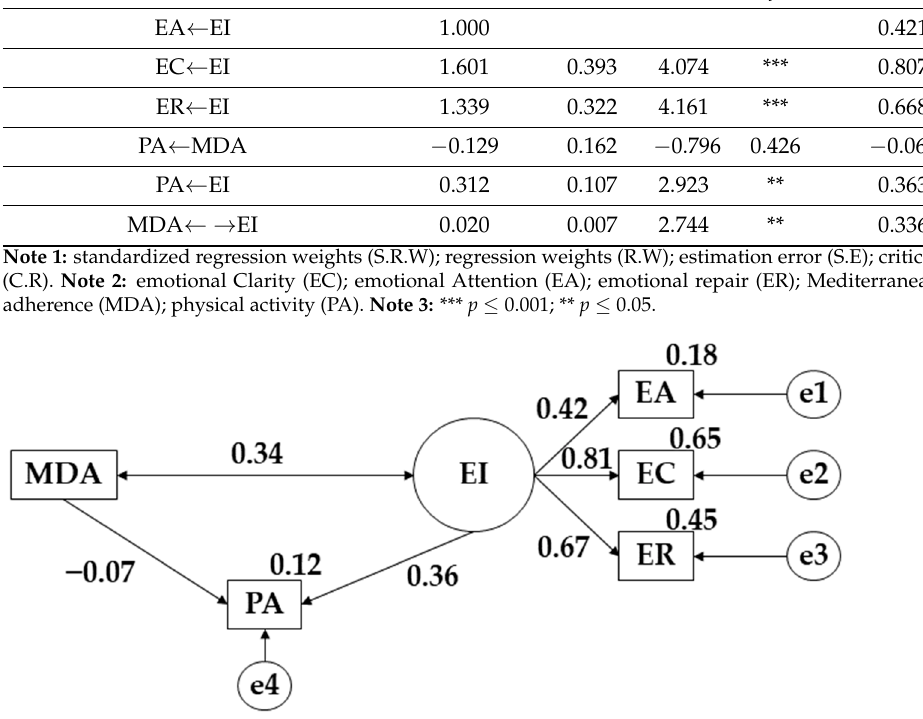
Table 2. Structural Equation Model Developed for the Male Population. Associations between Variables